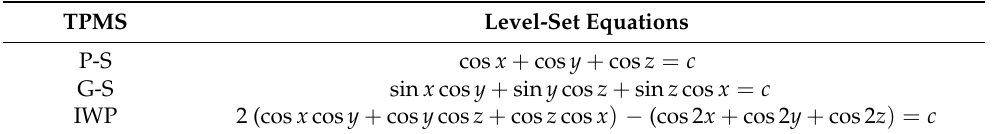
Table 2. Level-set equation for P-S, G-S, and IWP [4], where x , y , and z are Cartesian coordinates, and c is the level-set constant that controls the thickness of TPMS